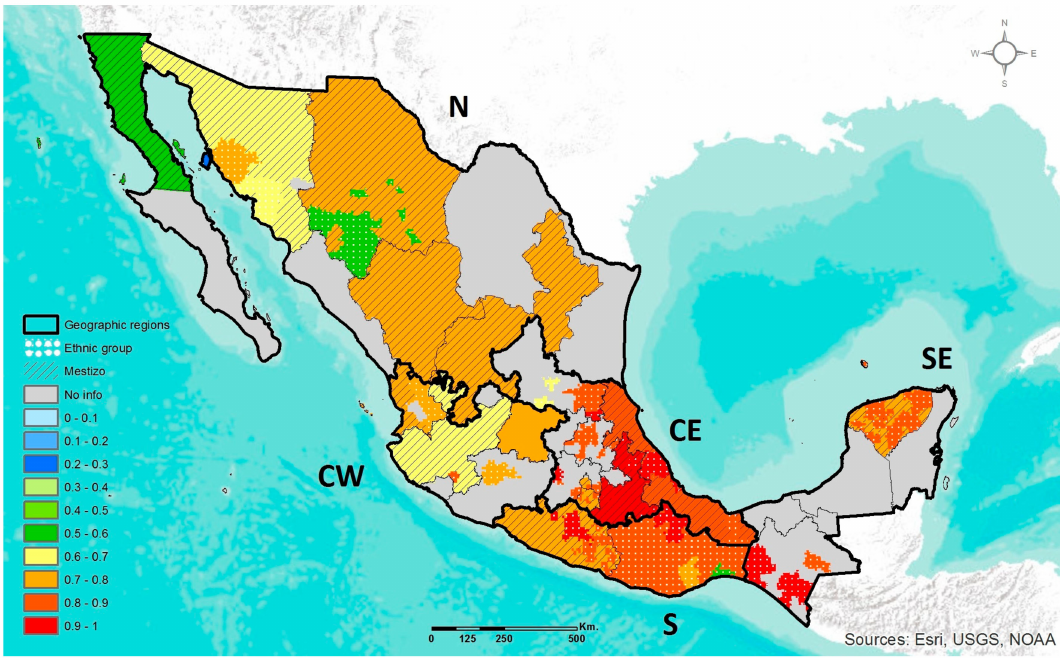
Figure 1. Geographic distribution of the MTHFR 677CT+TT genotypes frequency in ethnic groups and Mestizo population of Mexico. N, North; CW, Central West; CE, Central East; S, South; SE, South